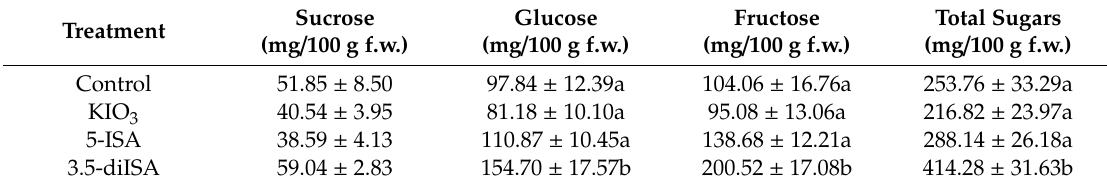
Table 4. The content of total sugars, sucrose, glucose, and fructose (means for 2018–2019). Treatment